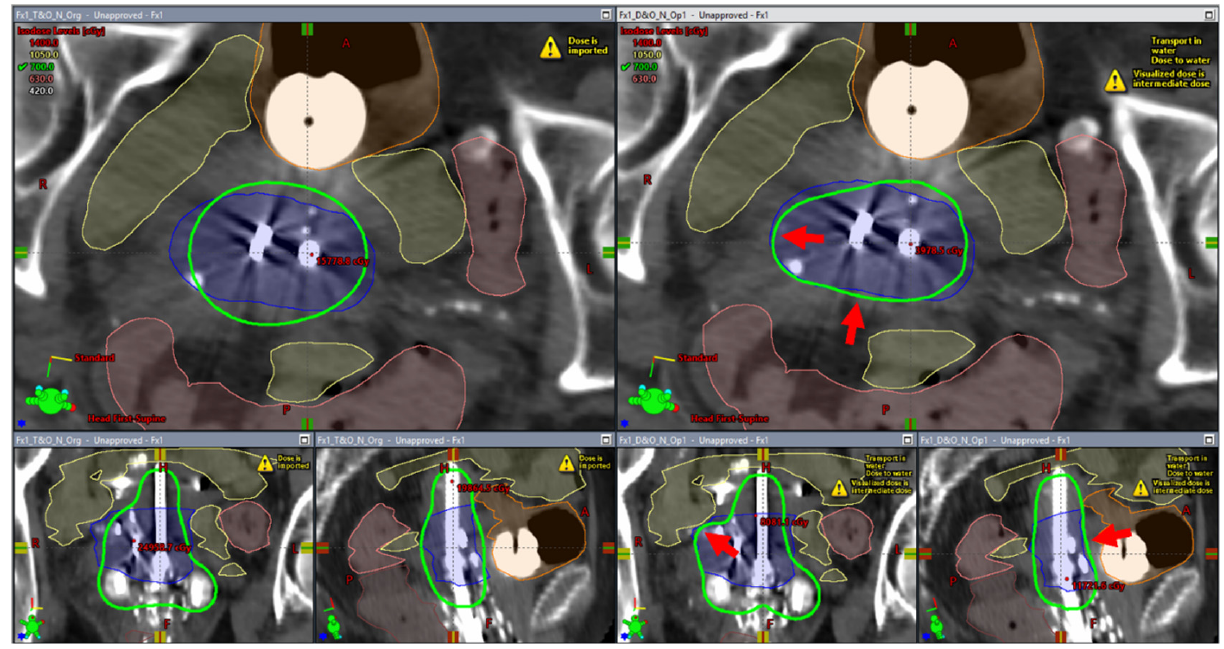
Figure 3. The difference in dosimetric conformality achieved by the original clinical plan (left) and the plan optimized with the direction modulated brachytherapy (DMBT) tandem, ovoids, and the two needle tracks (right). The blue contour is the CTV HR while the green is the 100% isodose line. The four red arrows on the right image set indicates notable improvements in dose conformality enabled by the proposed workflow where optimal positioning of the needles (top and bottom left) and the intensity modulation enabled by the DMBT tandem around its vicinity (bottom right) are well observed.